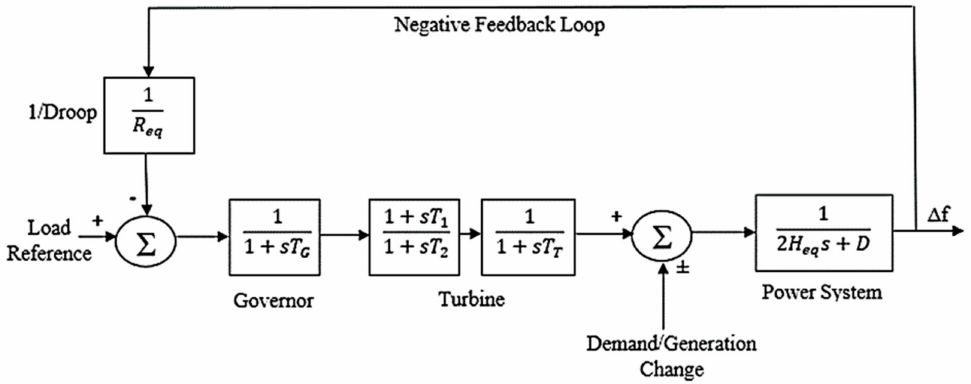
Figure 5. A generic turbine-governor power system